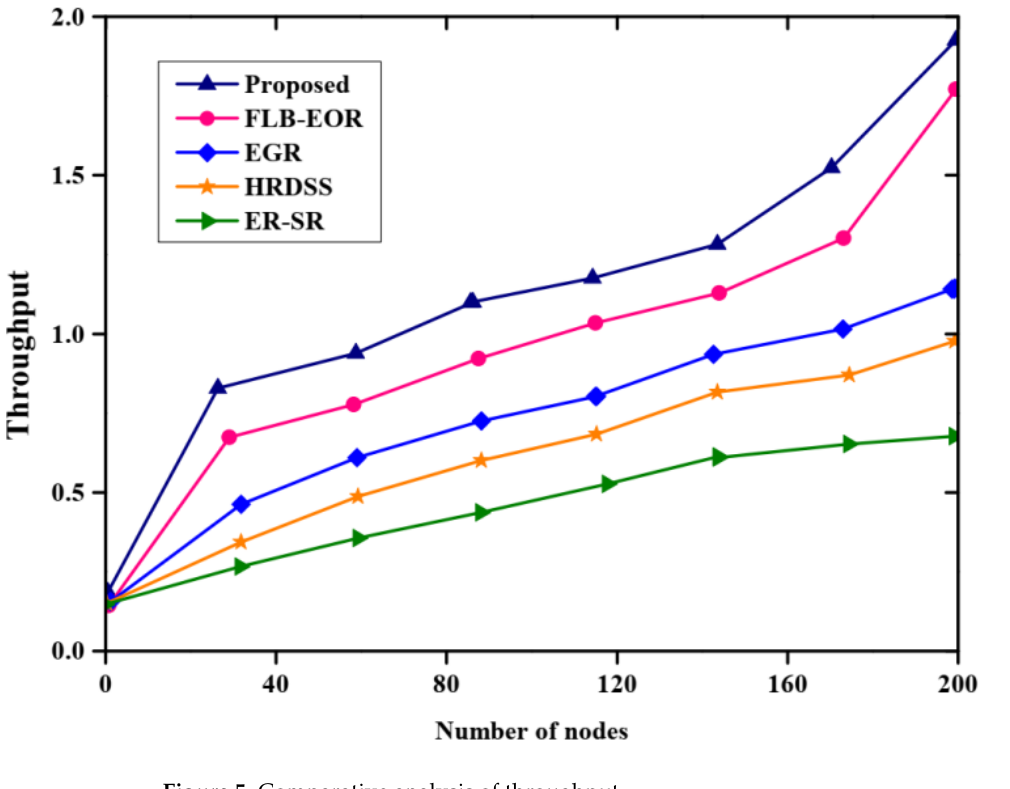
Figure 5. Comparative analysis of throughput. Table 5. Comparative results based on throughput.